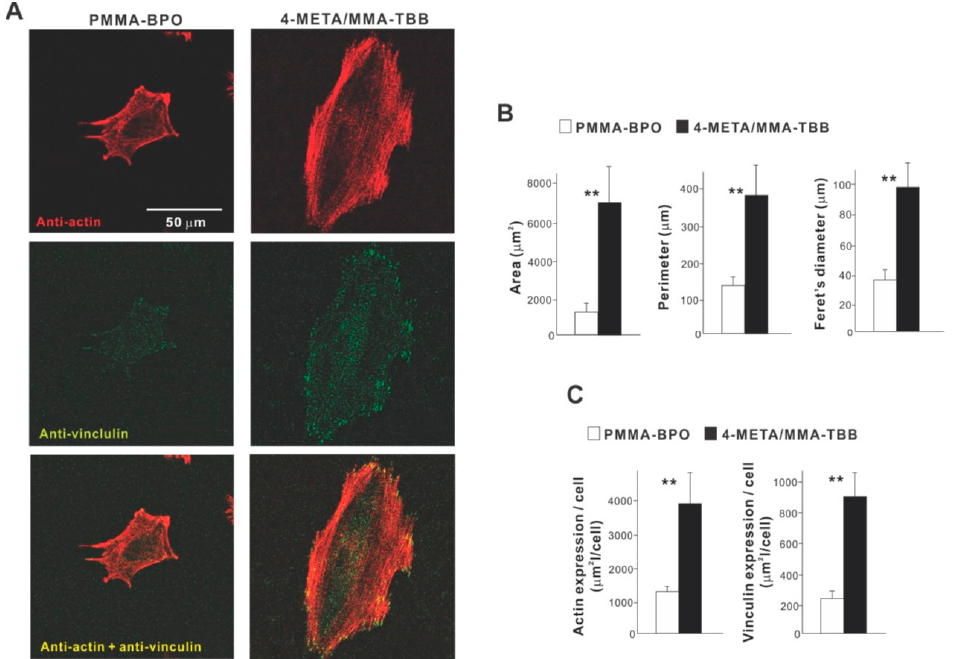
Figure 4. Attachment and spreading behavior of osteoblasts on two different materials. ( A ) Confocal microscopic images of osteoblasts with immunochemical staining for cytoskeletal actin and the adhesion protein vinculin are shown. Cytomorphometric ( B ) and densitometric ( C ) parameters measured from the images are presented. ** p < 0.01, statistically significant difference between the two materials.